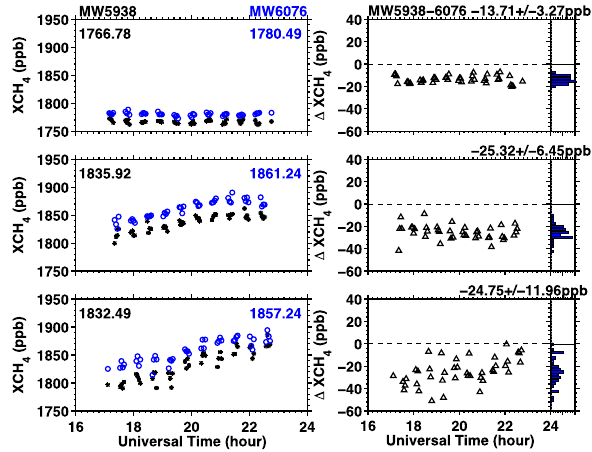
Fig. 10. The spectral fitting residuals (left panels) and their corre- lation, Pearson’s correlation coefficients ( R ), and histograms (right panels) with MW5938 (top panels) and MW6076 (bottom panels) for CH 4 slant column density measurements. In left panels, black curve is for Spectralon ® viewing; blue curve is for west Pasadena; gold curve is for the Santa Anita Park. In right panels, blue stars are the correlation between Spectralon ® and west Pasadena; gold cir- cles are the correlation between Spectralon ® and Santa Anita Park; the black dash lines indicate the one-to-one correlation. The spectral fitting residuals were generated using the co-addition of residuals of 41 spectral fittings of Spectralon ® target, 41 spectral fittings of west Pasadena target, and 40 spectral fits of the Santa Anita Park target on 3 January 2013. The systematic residuals arise from the imper- fect line shape function and spectroscopic parameters in addition to uncertainties in atmospheric pressure and temperature parameters since the magnitude and positions of spiky fitting residuals consis- tently appear in all three target scenes. However, the magnitude of most systematic fitting residuals is within 0.5% of spectral contin- uum levels.